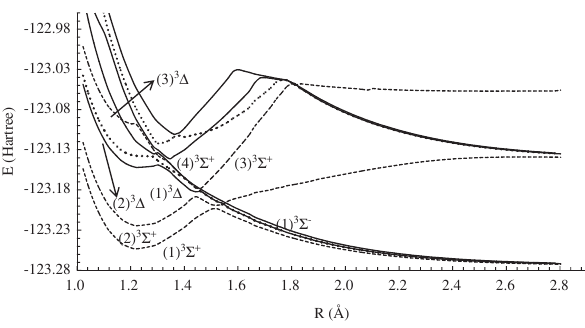
Figure 2: Potential energy curves of the electronic states 3 Σ ± and 3 Δ of the molecule BF.